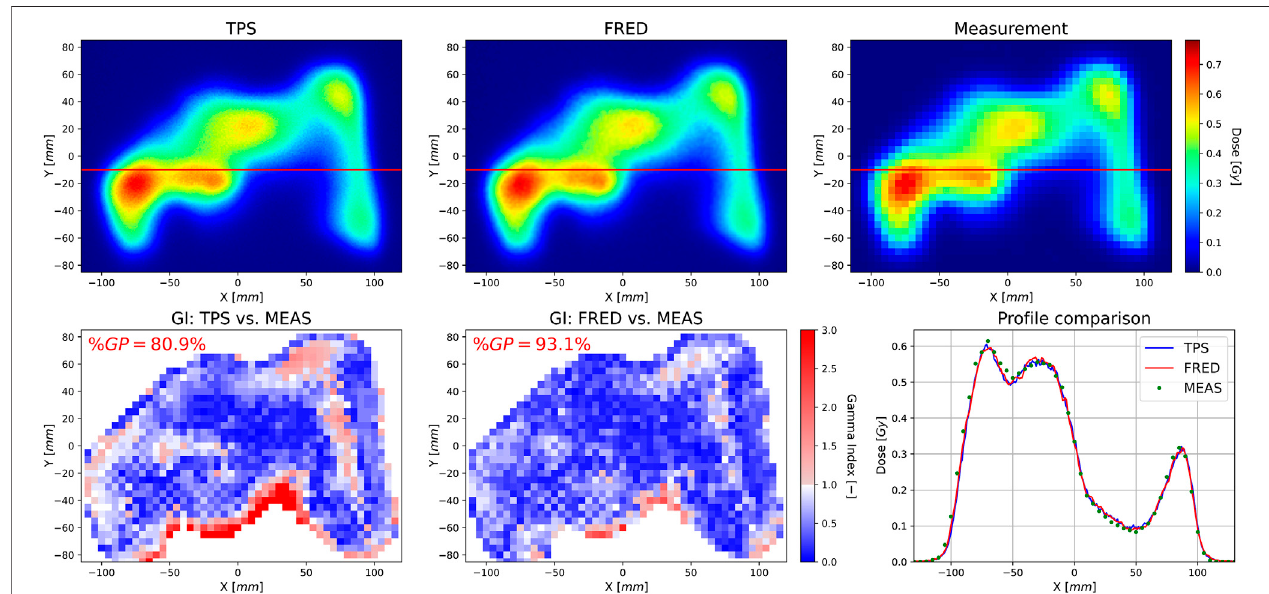
FIGURE 8 | Transverse 2D dose distribution layer calculated by the TPS (upper left) obtained from F RED MC simulations (upper middle) and measured with an arrayofionizationchambers inthewaterphantom (upperright) ,aswellasaGImapcomputed comparingtheTPS (lowerleft) and FRED (lowermiddle) simulationsto the measurement using the GI (2%/2 mm) method. The gamma passing rate (%GP) indicates the percent of pixels passing the GI test. The lower right panel shows dose pro fi les along the red line indicated on the upper